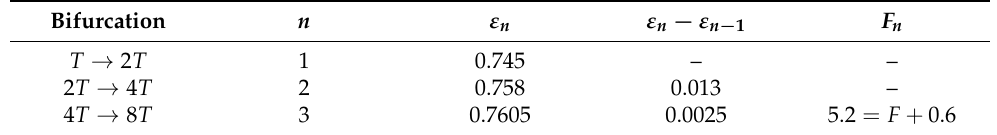
Table 3. Estimation of the ε